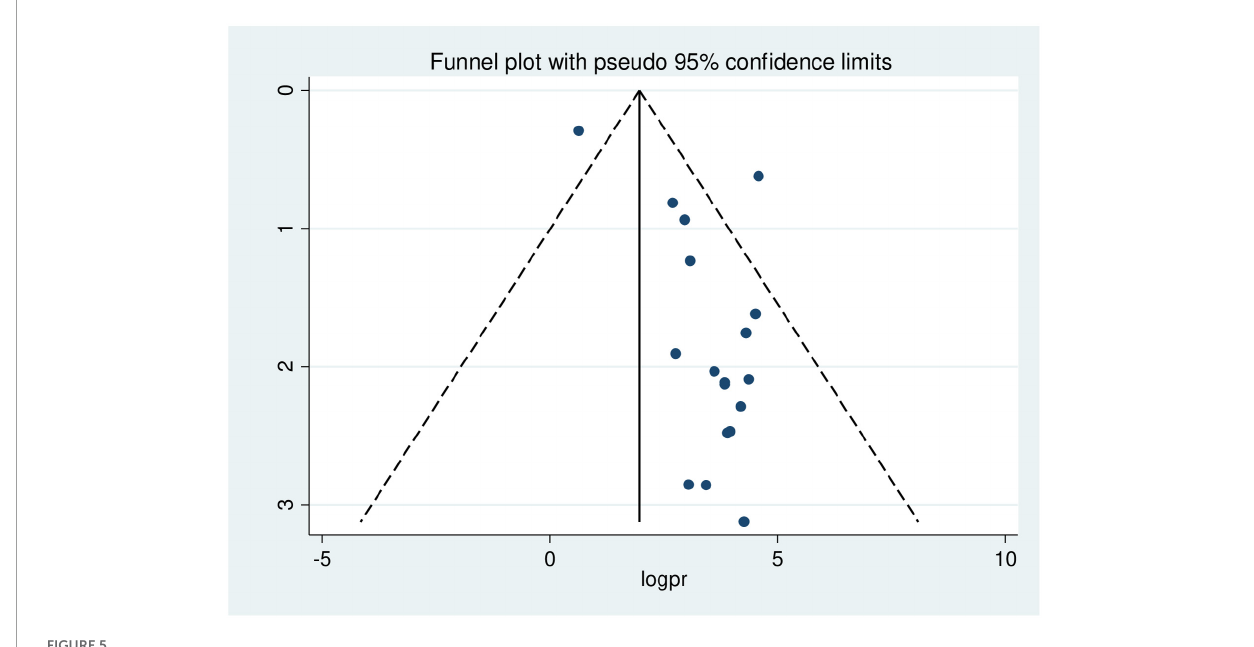
FIGURE5 Funnel plot showing asymmetrical distribution of studies indicating the presence of publication bias.